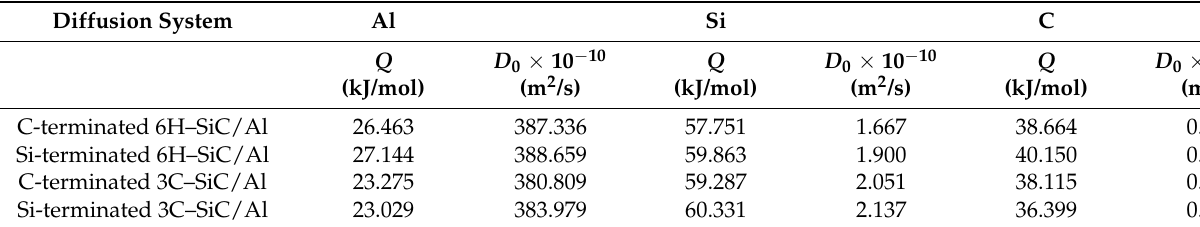
Table 2. Diffusion activation energies and pre-exponential factors of Al, Si, and C.